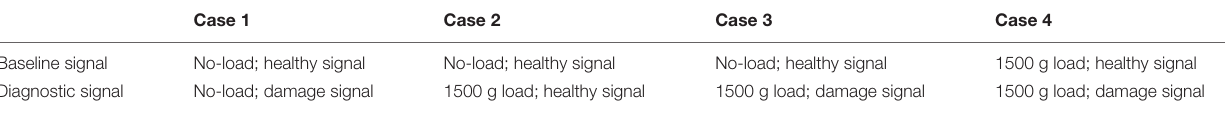
TABLE 3 | The baseline and diagnostic signals of different